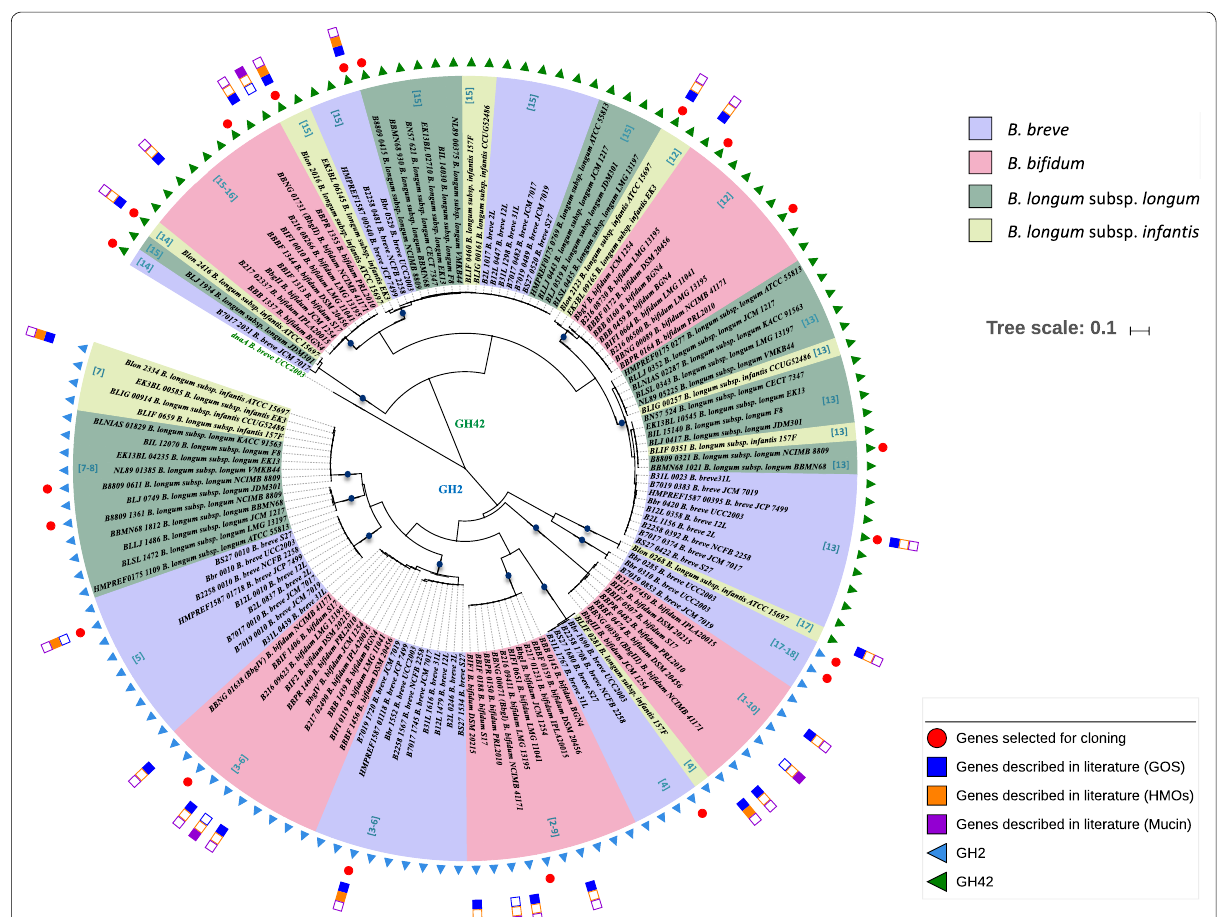
Fig. 2 Phylogenomics of β-galactosidases. Neighbour-joining tree based on the alignment of 137 putative β-galactosidases identified across 34 members of infant-derived bifidobacterial (sub)species. A red circle highlights the genes used for experimental assessment in this study, while blue and orange squares identify those genes of which involvement in the assimilation of GOS and HMOs have been reported in literature. Circles on the phylogenetic tree highlight nodes with bootstrap values above 90% and dark blue circles identify the 14 phylogenetic groups defined by our